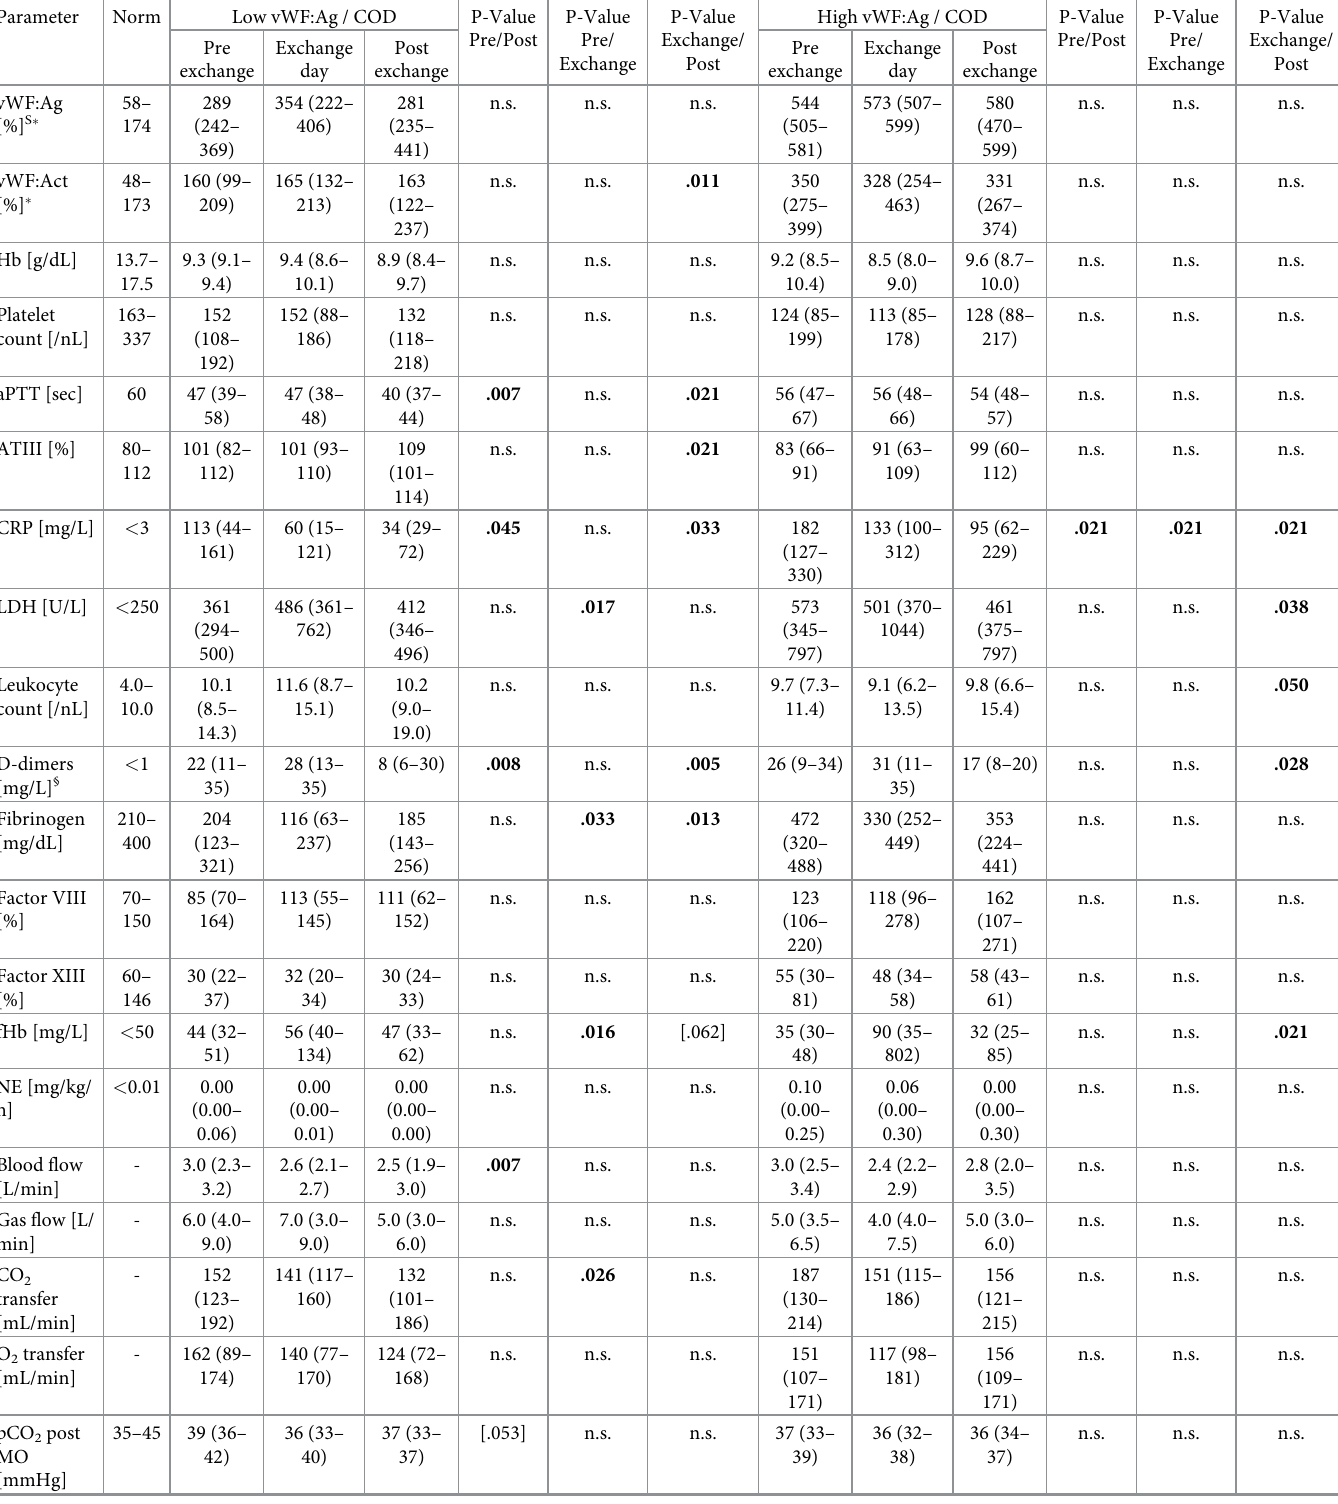
Table 3. A. Ventilation-related data and laboratory parameters pre and post MO exchange in COD patients. B. Ventilation-related data and laboratory parameters pre and post MO exchange in WGT